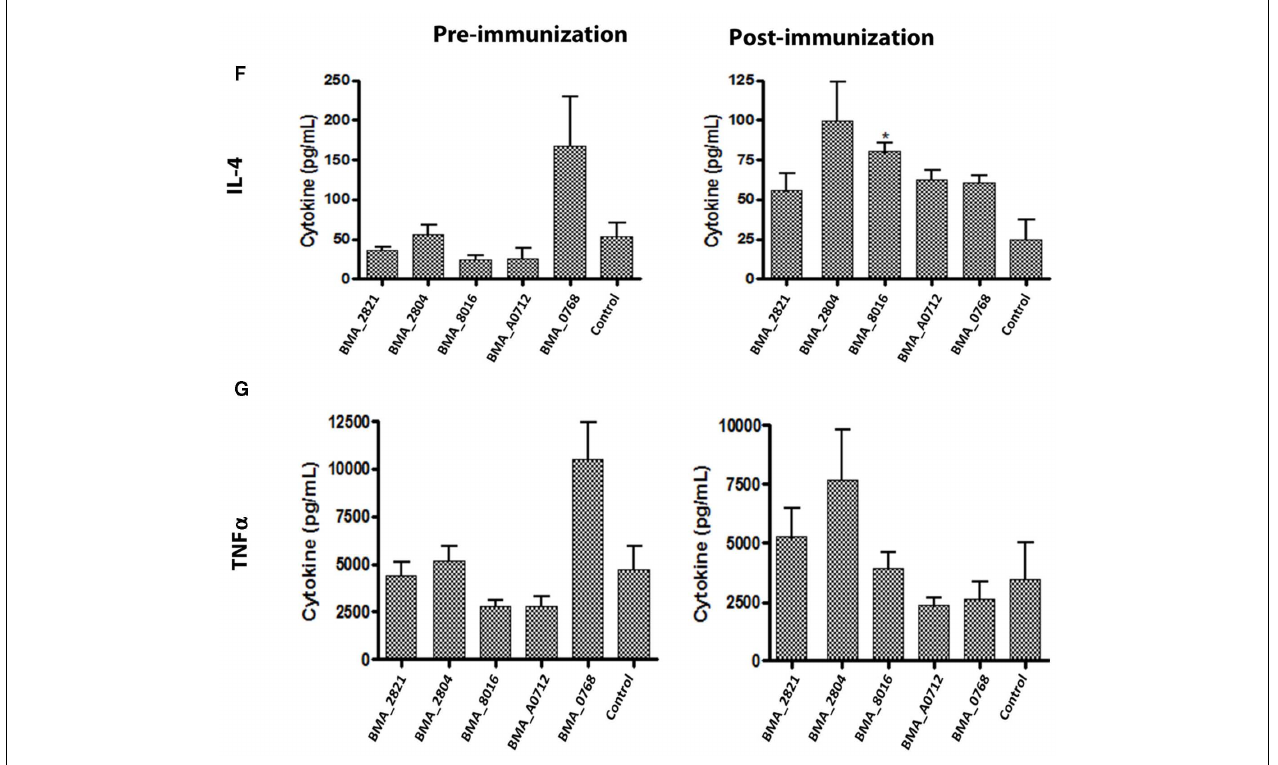
adjuvant-immunized mice. Replicates of three animals per group per time point were used to determine the level of cytokine or chemokine indicated above each pair of graphs (A) through (G) . Sera were collected and analyzed per manufacturer’s instructions. Unpaired Student’s t -test was utilized to determine significance ( p < 0.05). Error bars are SD with group